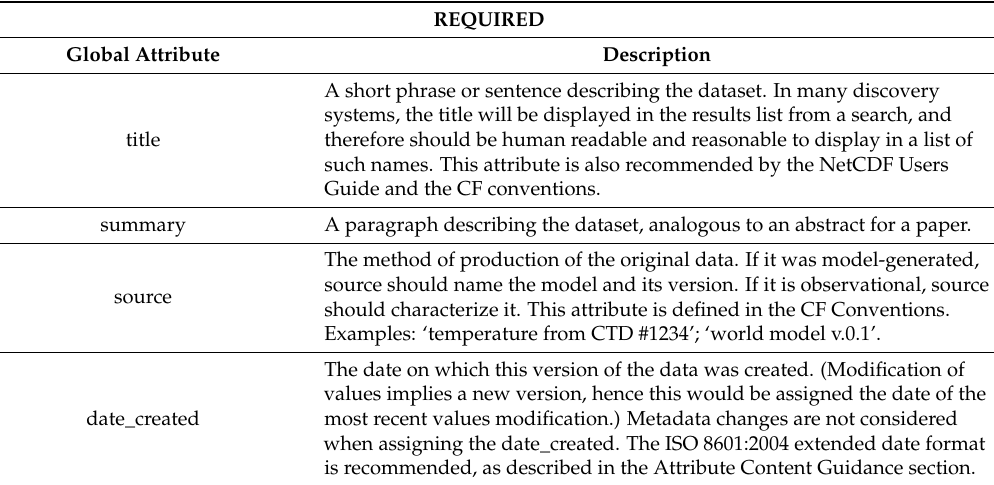
Table A1. The following table contains a subgroup of attributes from the ACDD metadata specification [16] where the priority-level for the attributes are categorized as “Required”, “Recommended”, or “Suggested” and which shows attributes where the priority-level has been modified to better align with NCI’s data hosting services (e.g., NCI classifies “source” as “Required” while it is only “Recommended” by the ACDD